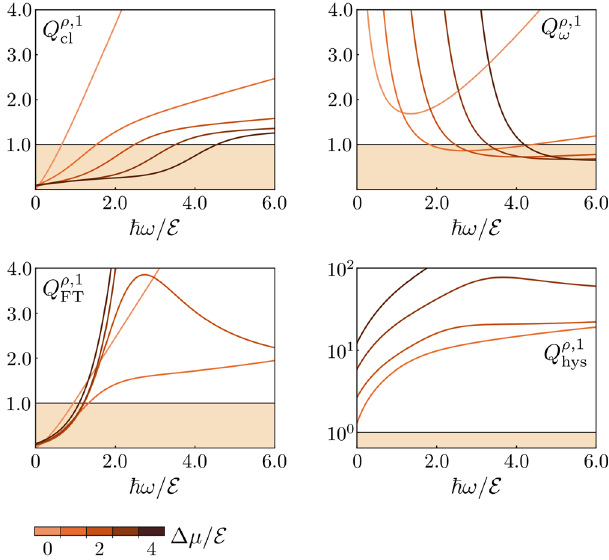
FIG. 6. Quantum generator in perspective. The four plots from top left to bottom right show the coefficients (93a) – (93d) for x ¼ ρ and α ¼ 1 as functions of the driving frequency for T= E ¼ 1 = 2 , μ ¼ 0 and different biases Δ μ = E ¼ 0 ; 1 ; … ; 4 , where E was defined in Fig. 5. In each plot, the shaded area indicates the putative lower bound 1 on the corresponding